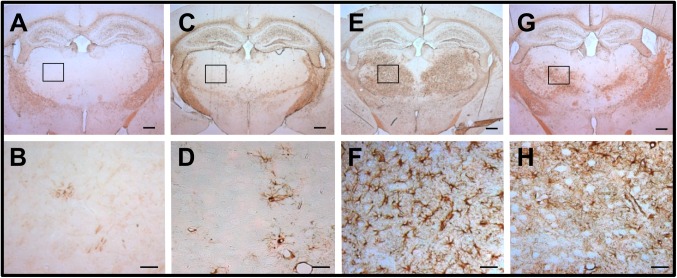
GFAP-immunoreactive astrocytes in the ventral anterior-lateral complex of the thalamus (VAL) of WT, homozygous Slc19a3 KO, and Slc19a3 KI mice.A, C, E, G. Low-magnification images of reactive astrocytes in the thalamus of a WT mouse fed with a conventional diet at postnatal day 35 (A); a homozygous KO mouse fed with thiamine 0.60 mg/100 g food for 5 days (C) and for 12 days (E); and a KI mouse fed with thiamine 0.60 mg/100 g for 14 days (G). B, D, F, and H are high-magnification images of the VAL area (insets) shown in panels of A, C, E, and G, respectively. Scale bars, 500 μm (upper panel) and 100 μm (lower panel).